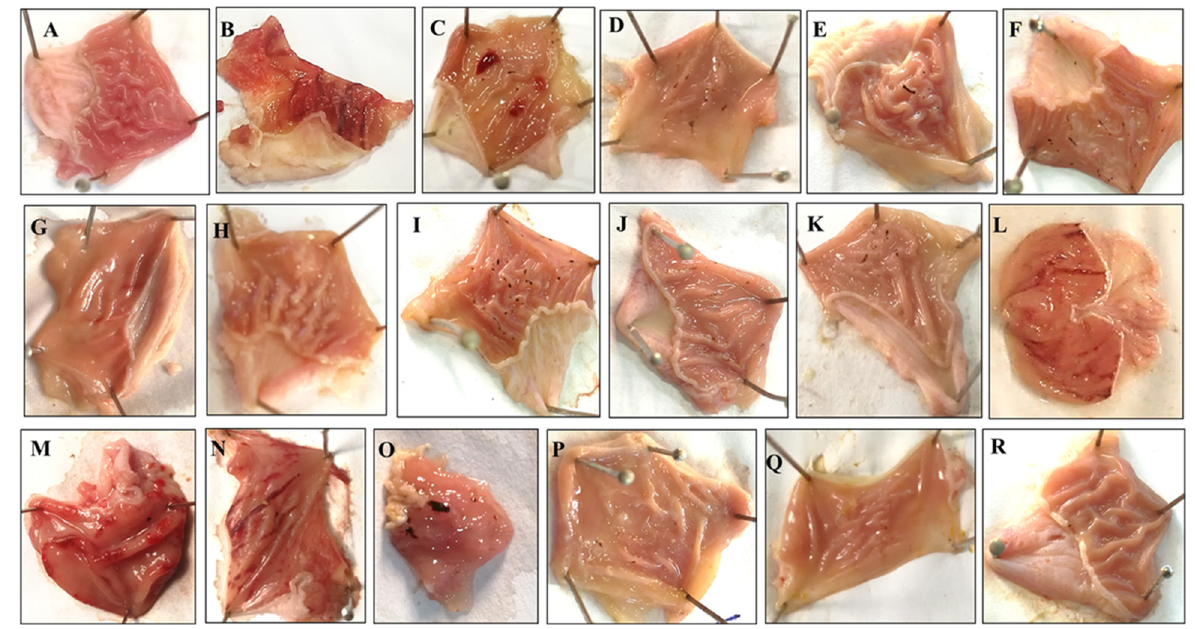
Figure 5. Gross-appearance of gastric mucosa in rats: Pretreated with ( A ) saline (10 mL/kg), ( B ) ethanol (1 mL/100 g) severe injuries are seen, as ethanol produced excessive hemorrhagic necrosis of gastric mucosa, pretreated with ( C ) Rumex hastatus crude extract (Rh.Cr 50 mg/kg), ( D ) Rh.Cr 100 mg/kg, ( E ) Rh.Cr 300 mg/kg and fractions: ( F ) n-Hexane (Rh.n-Hex 50 mg/kg), ( G ) Rh.n-Hex 100 mg/kg, ( H ) Rh.n-Hex 300 mg/kg, ( I ) ethyl acetate (Rh.n-ETAC 50 mg/kg), ( J ) Rh.ETAC 100 mg/kg, ( K ) Rh.ETAC 300 mg/kg, ( L ) aqueous (Rh.Aq 50 mg/kg), ( M ) Rh.Aq 100 mg/kg, ( N ) Rh.Aq 300 mg/kg, ( O ) rutin 50 mg/kg, ( P ) rutin 100 mg/kg, ( Q ) rutin 200 mg/kg and ( R ) omeprazole 20